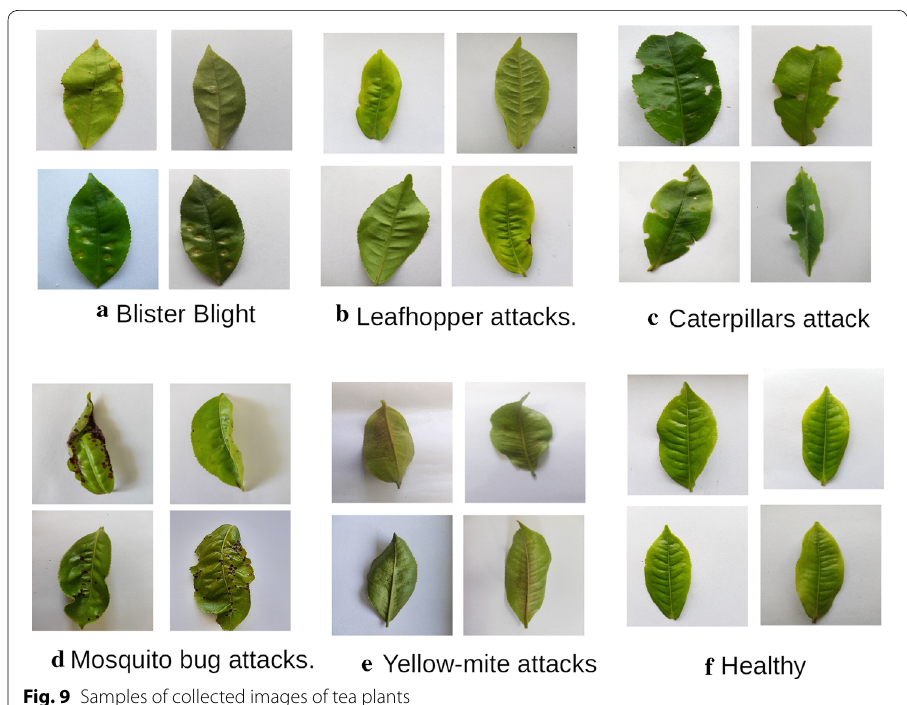
Fig. 9 Samples of collected images of tea plants